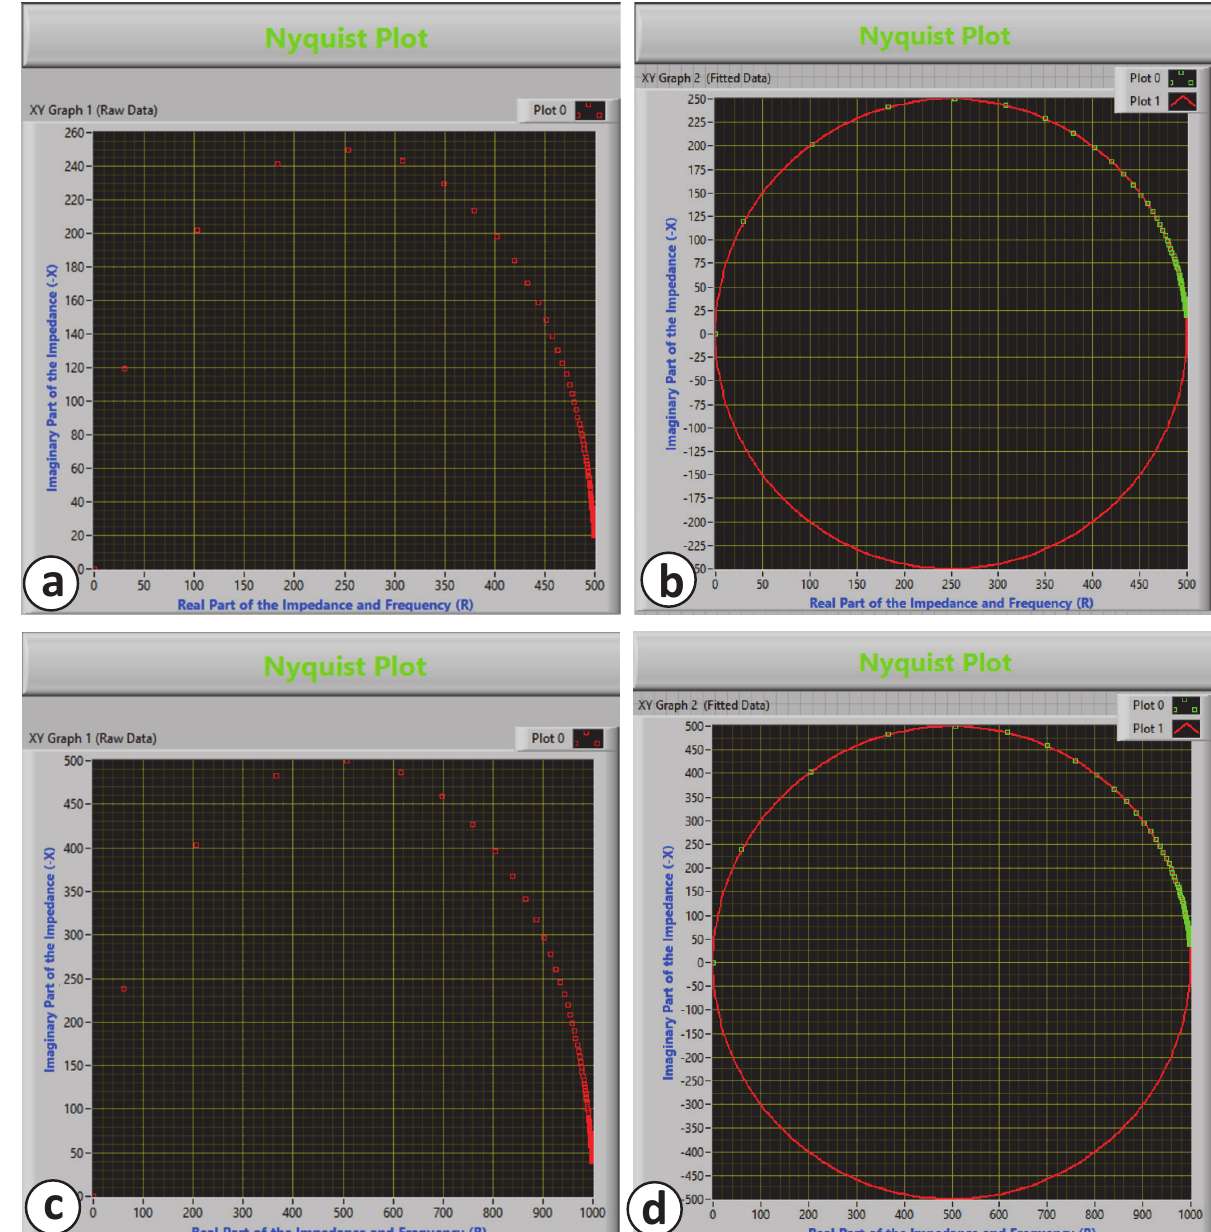
Fig.13: Nyquist plots of simulated (inductive) impedance data loaded in LEBISDI after fitting.